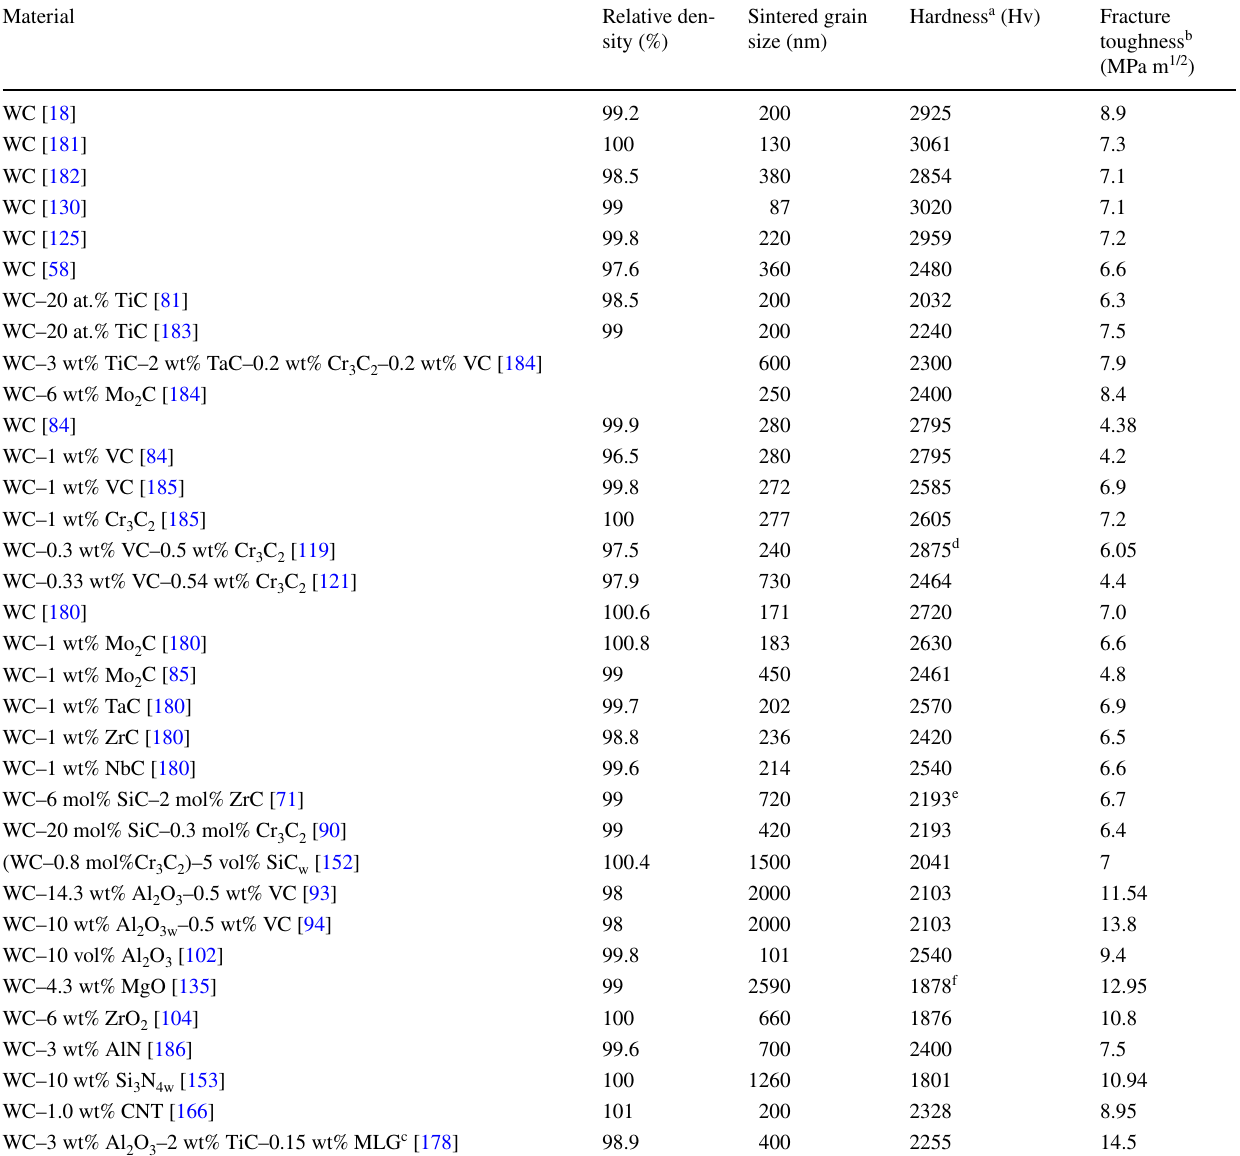
Table 6 Hardness and fracture toughness of some reported